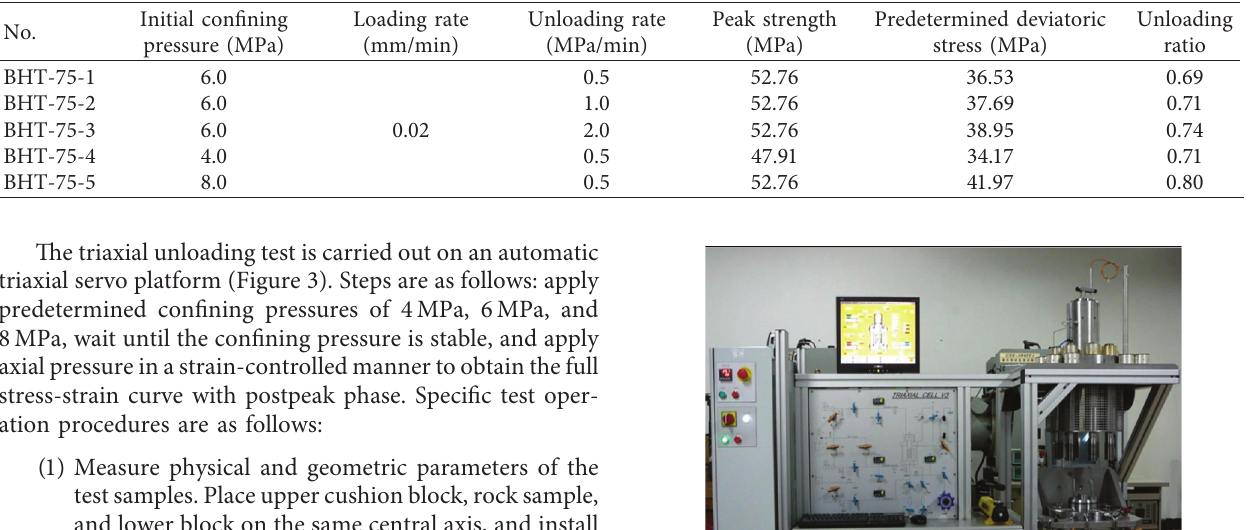
Table 3: Test plan of CJRM-like material samples.